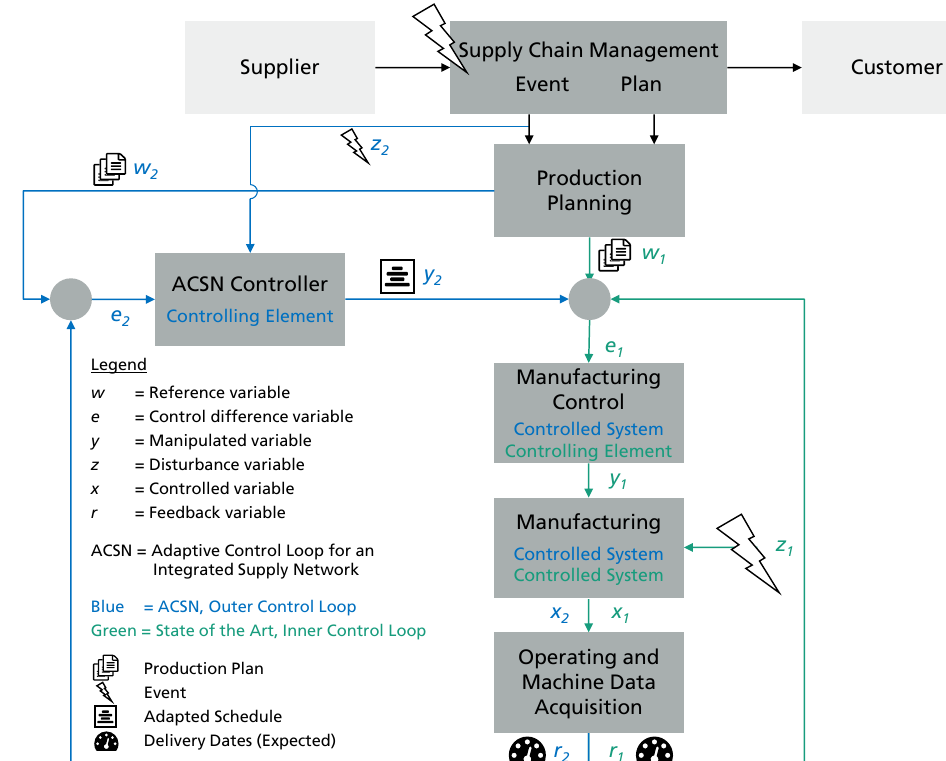
Figure 5. Adaptive control loop for an integrated supply